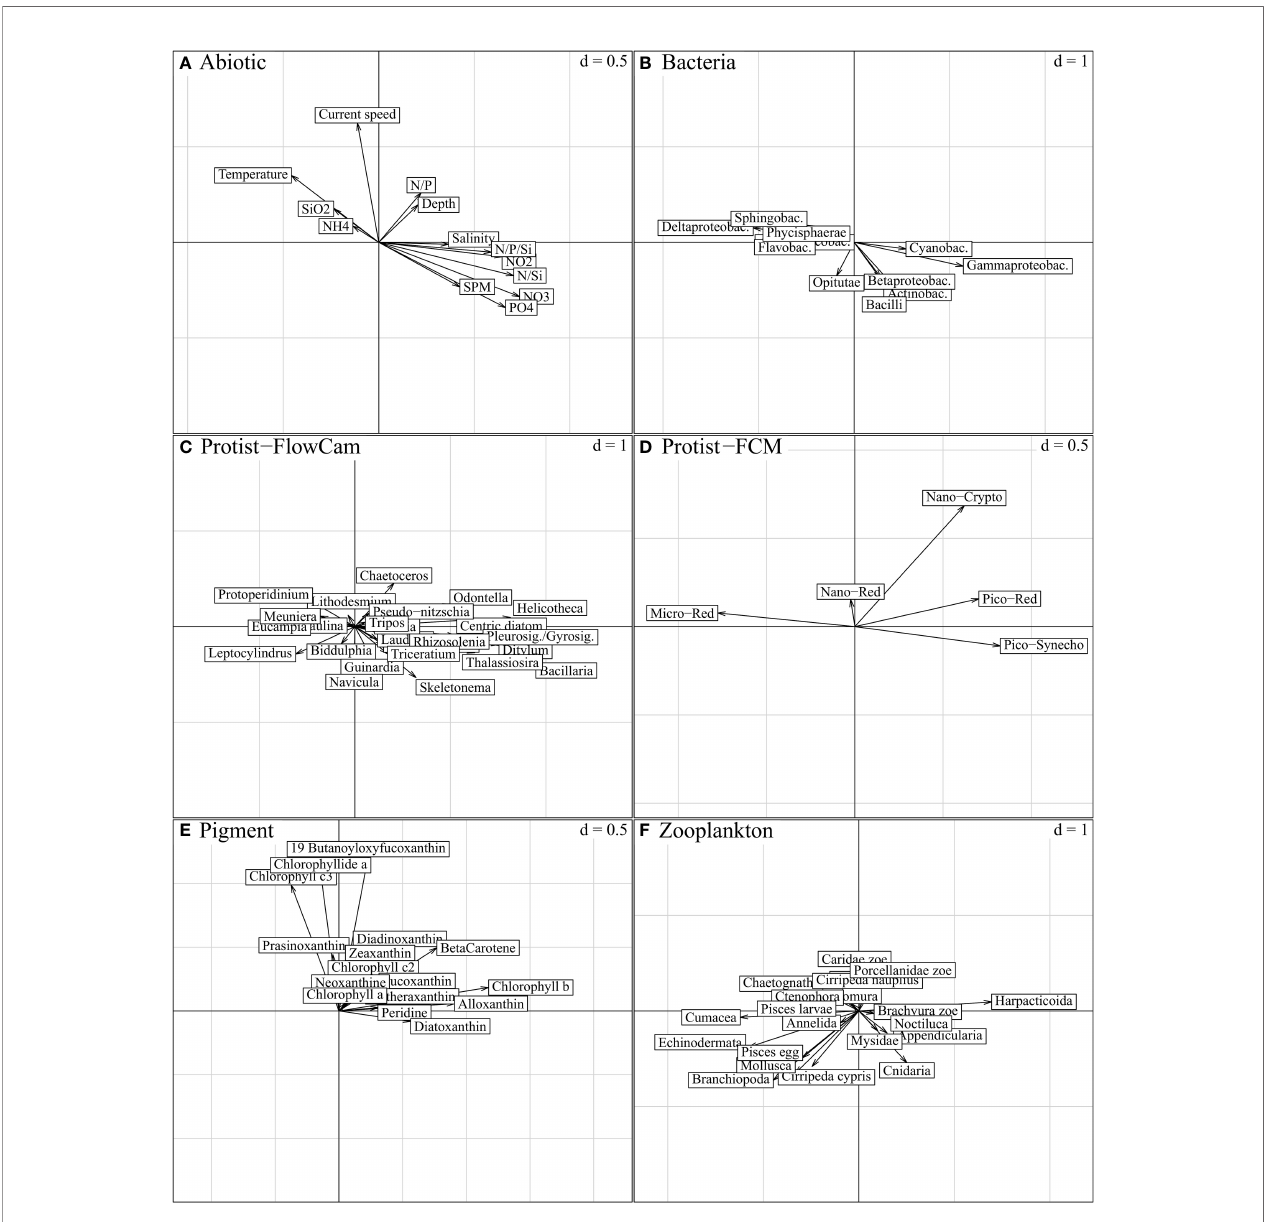
FIGURE 8 | STATIS compromise, projection of descriptors per ecosystem component on compromise axis 1 (horizontal) and axis 3 (vertical); “ d ” indicates the grey grid scale, i.e. the axis unit. The variables expressed on these axes characterize the spatial variations in Figure 5B (axis 1; from left to right, east-west gradient) and Figure 5D (axis 3; down-top, north-south gradient), respectively. Axis 1 is mainly characterized by nutrient load variations, and associated biotic entities are best represented by the longest and respectively collinear vectors in (B – F) . As emphasized in Figure 6 ( “ STATIS axes 1-3 ” ), only Protist-FCM and Pigment components are substantially expressed on both axes. Axis 3, with limited abiotic signi fi cance, is mostly a combination of Nano-Crypto protists (D) and some pigments (E)